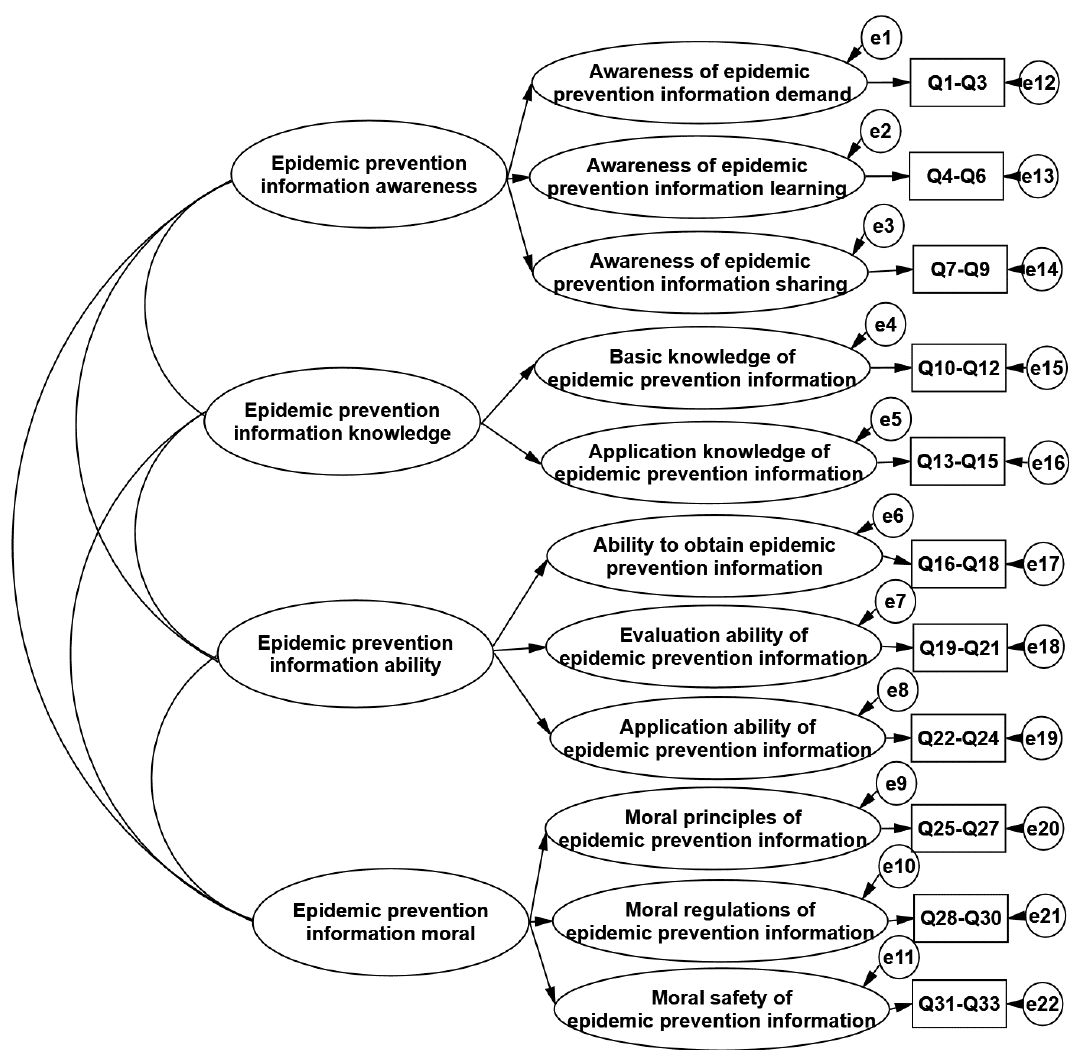
Figure 1. Second-order-model diagram of confirmatory factor analysis.